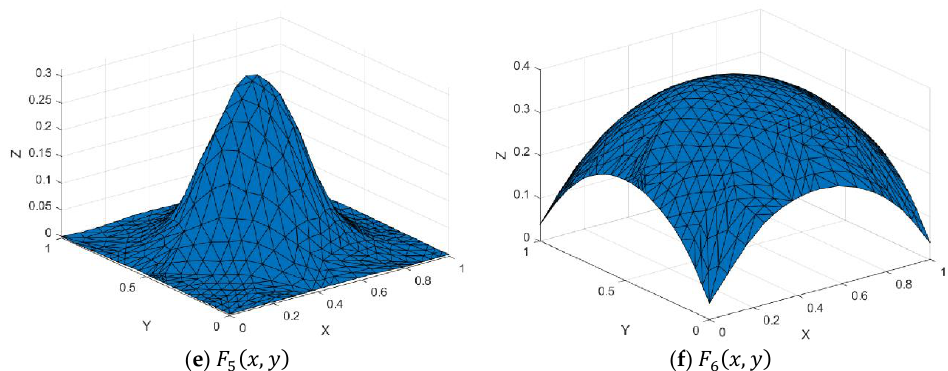
Figure 16. Surface interpolation using Goodman and Said method and Choice 1 for 65 datasets.